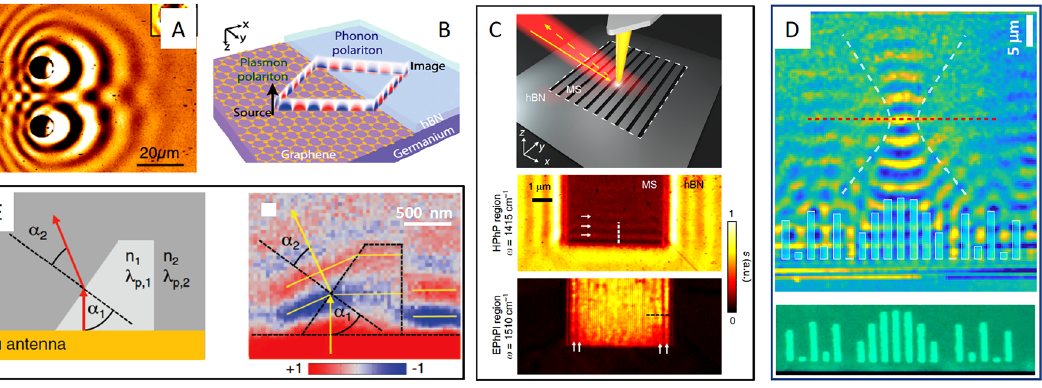
Figure 9: Infrared nanoimaging of polaritonic waves. PanelA:nano-IRimageoftheinterferencepatternofsurface phononpolaritons onaSiClaunchedbycircularAudiscs[331].PanelB:predictionofin- plane negative refraction between plasmon polaritons in graphene and phonon polaritons in an hBN slab [455]. Panel C: nano-IR imaging of polaritonevolutionandcanalizationinanhBNmetasurface[248].PanelD:opticalimagesofthelaser-writtenmetalense(bottom).Nano-IRimageof revealing focusing of phonon polaritons at 1452 cm − 1 [456]. Panel E: refraction of graphene plasmon polaritons at the prism formed by bilayer graphene